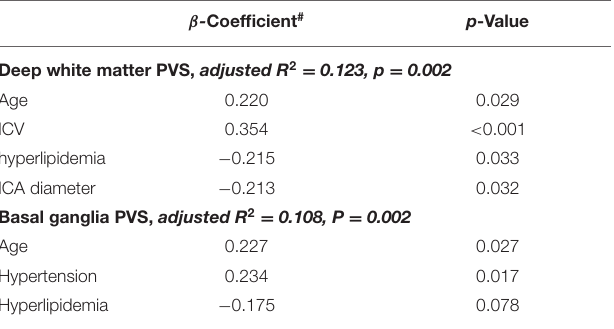
TABLE 3 | Results of multiple regression